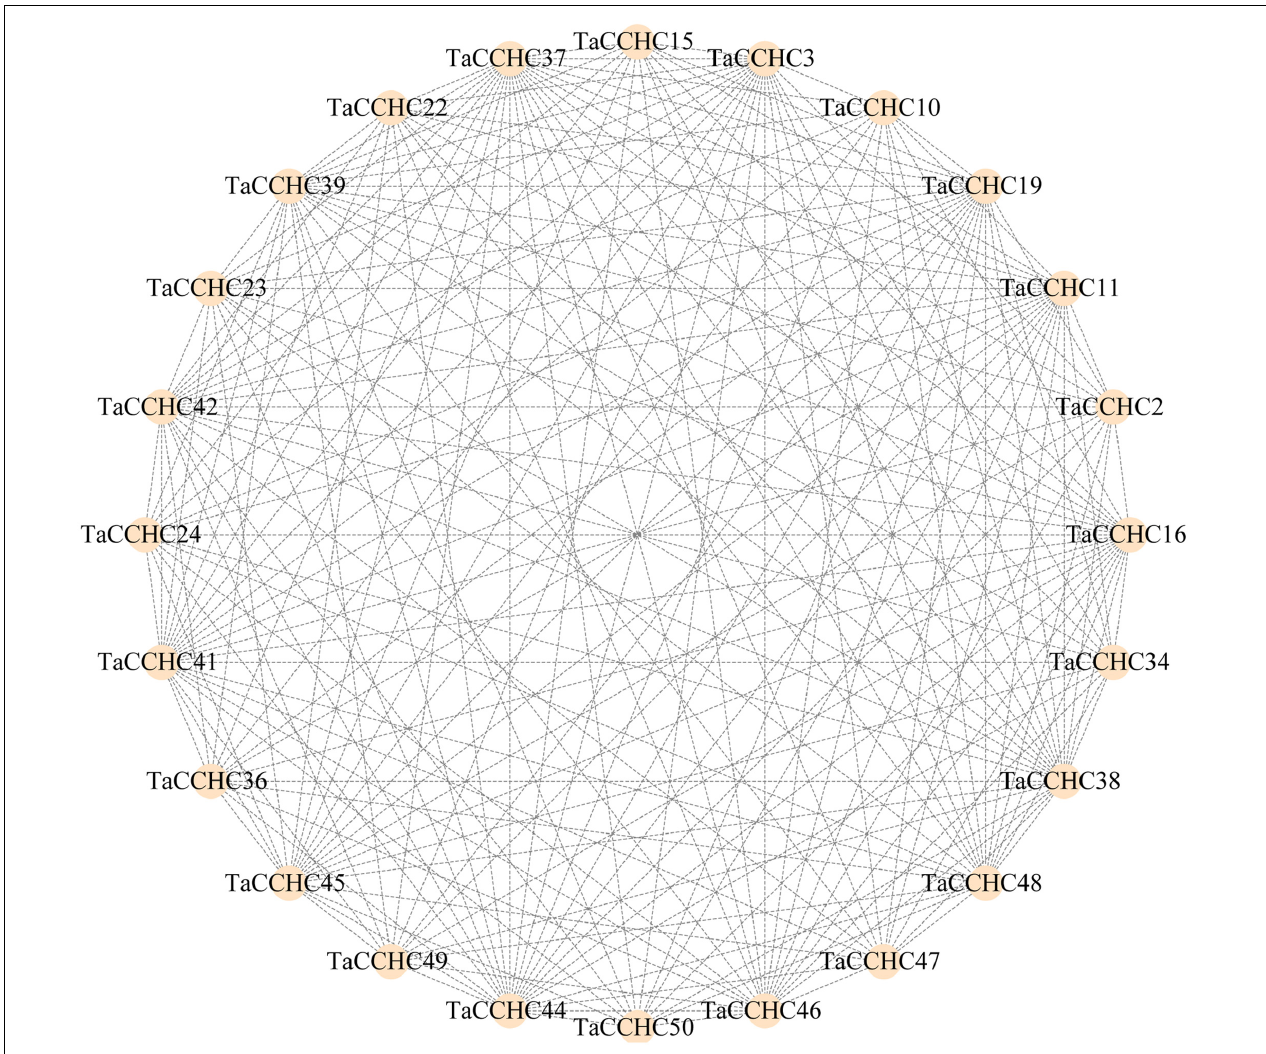
FIGURE 8 | Interaction network of TaCCHC-ZFPs. A total of 202 interactions are displayed among 24 TaCCHC-ZFPs. The protein-protein interaction networks of wheat CCHC-ZFPs were predicted using the STRING tools with high confidence (0.700; Szklarczyk et al., 2019), and was used to visualized by the Cytoscape with default parameters (Shannon et al.,